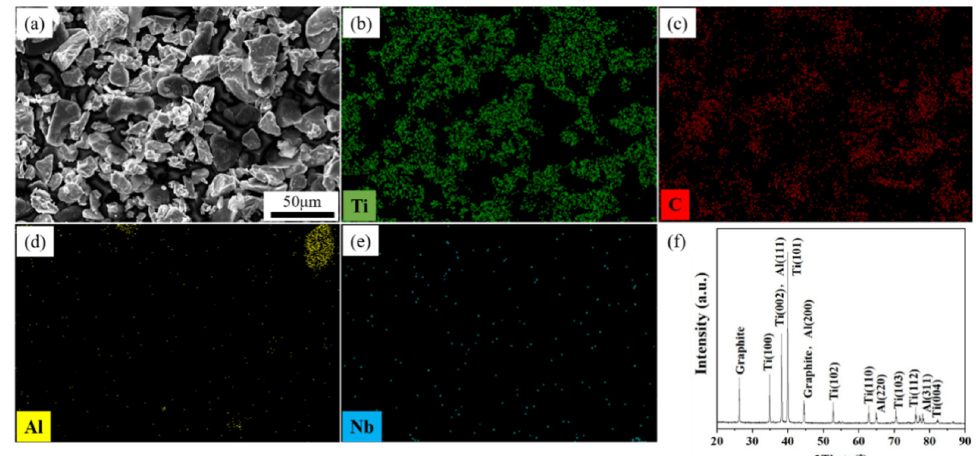
Figure 3. Mixed powder: ( a ) SEM image, ( b ) Ti element in EDS map, ( c ) C element in EDS map, ( d ) Al element in EDS map, ( e ) Nb element in EDS map, ( f ) XRD pattern.